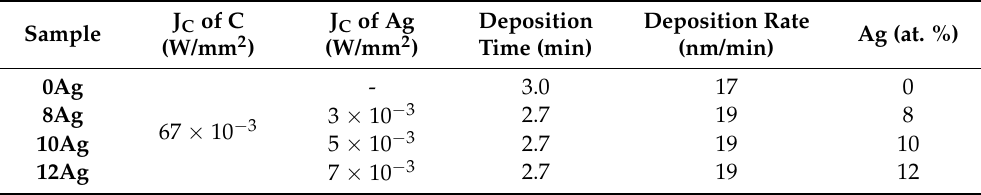
Table 1. Experimental details of Ag/DLC films deposition, prepared by